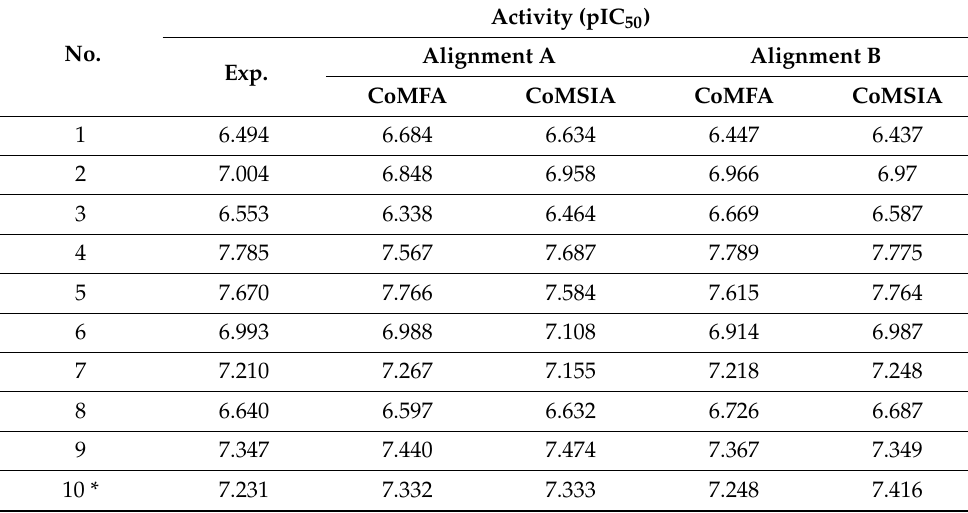
Table 1. The studied chemical IDs (the detailed molecular structures were listed in the Supplementary Material) and corresponding experimental/predicted inhibition